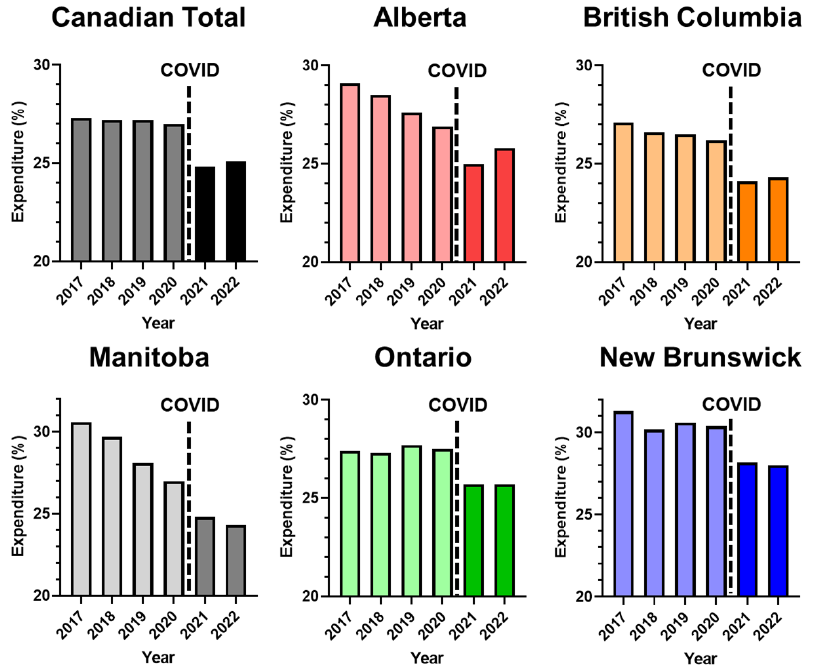
Figure 3. Percentage of healthcare expenditure allocated towards hospital spending, from 2017–2022. Data for 2021–2022 are official estimates.